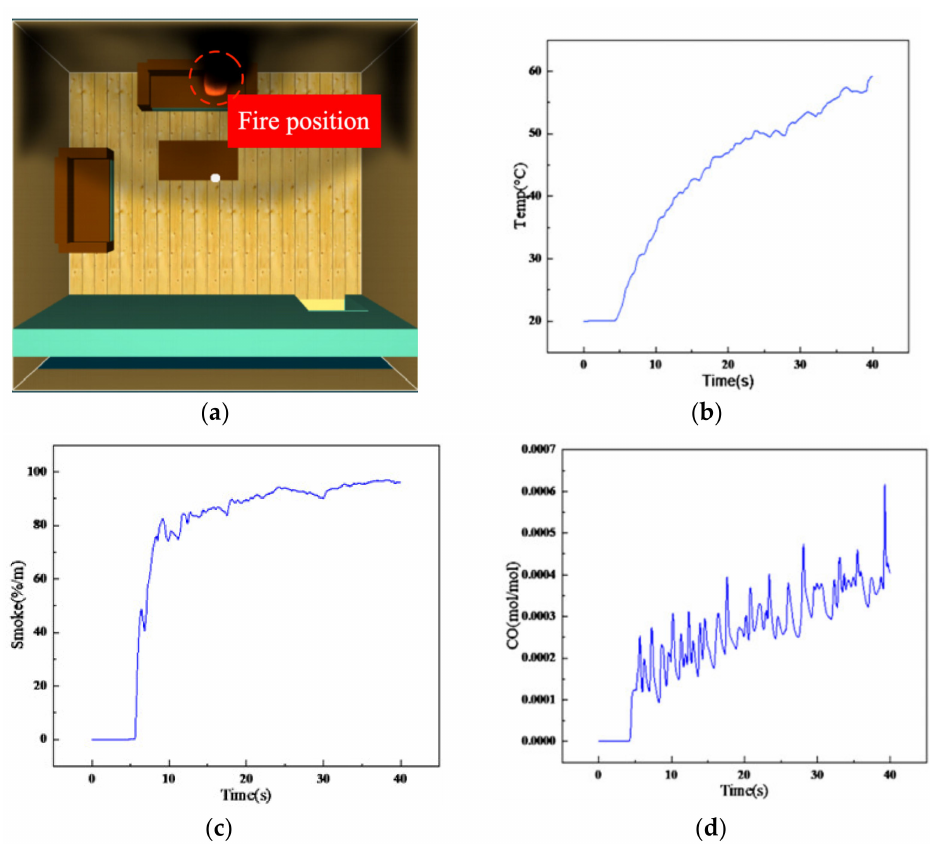
Figure 6. The simulation analysis of in-building fire features: ( a ) fire model; ( b ) temperature change; ( c ) smoke concentration change; and ( d ) carbon monoxide